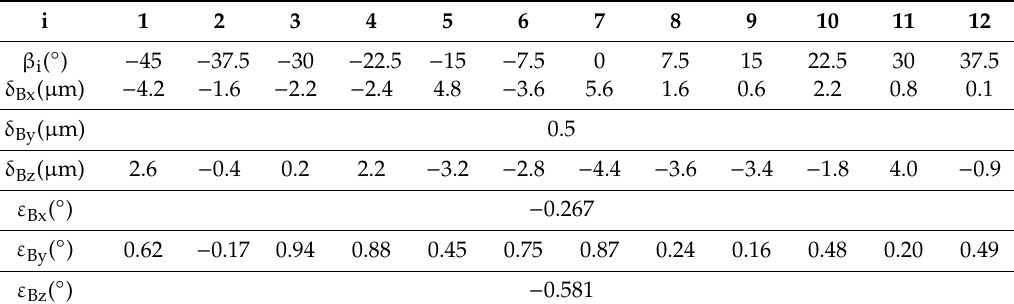
Table A5. Complete geometric errors of the B-axis.